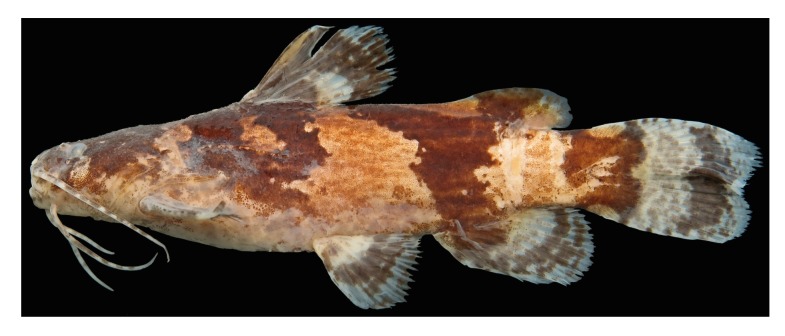
Microglanis cottoides, MZUEL 7453, 54.6 mm SL.Specimen collected in the Arroio Divisa, Camaquã River basin, Cristal, RS, 30o54'5.6"S 52o05'18.9"W (Photo by O.A. Shibatta).